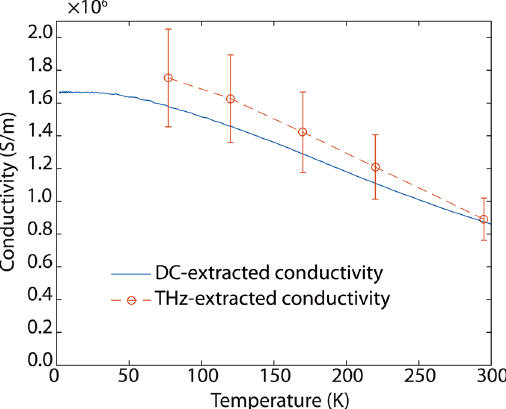
Figure 4. THz-extracted and DC-extracted conductivity vs. temperature for Sample #1 . THz-extracted conductivity levels from TDS measurements statistically agree with those observed in DC measurements; this observation is different to our previous observations in complex oxide 2DEGs, where a much larger THz- extracted conductivity was